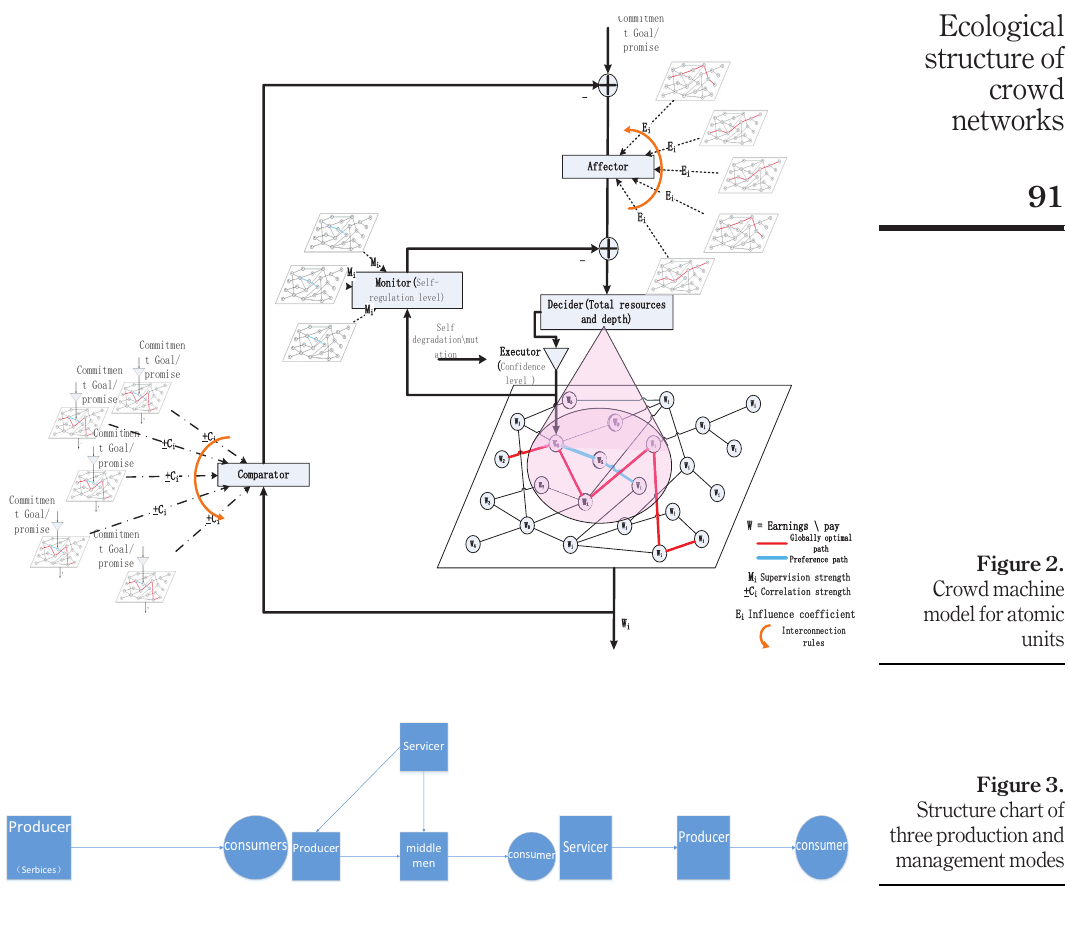
Figure 2. Crowd machine model for atomic